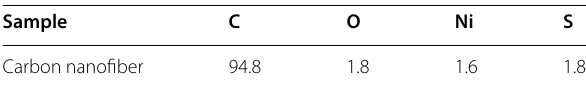
Table 1 Surface composition (in